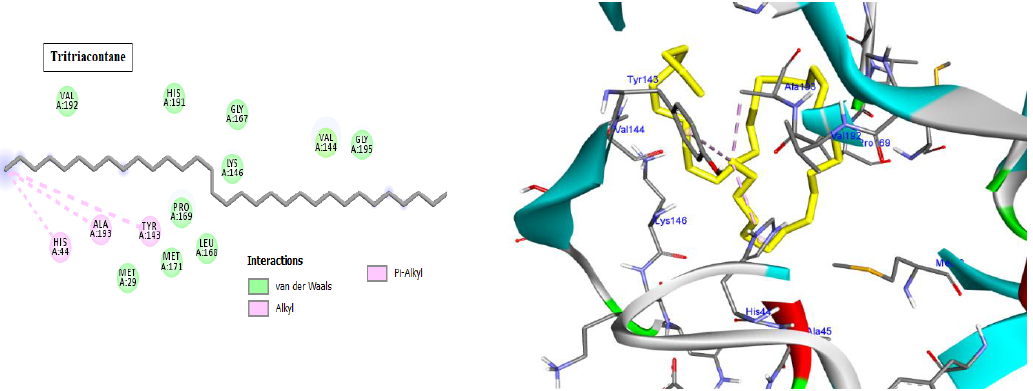
Figure 7. Two-dimensional and three-dimensional images of tritriacontane docked into the HAV 3C protease enzyme binding site.